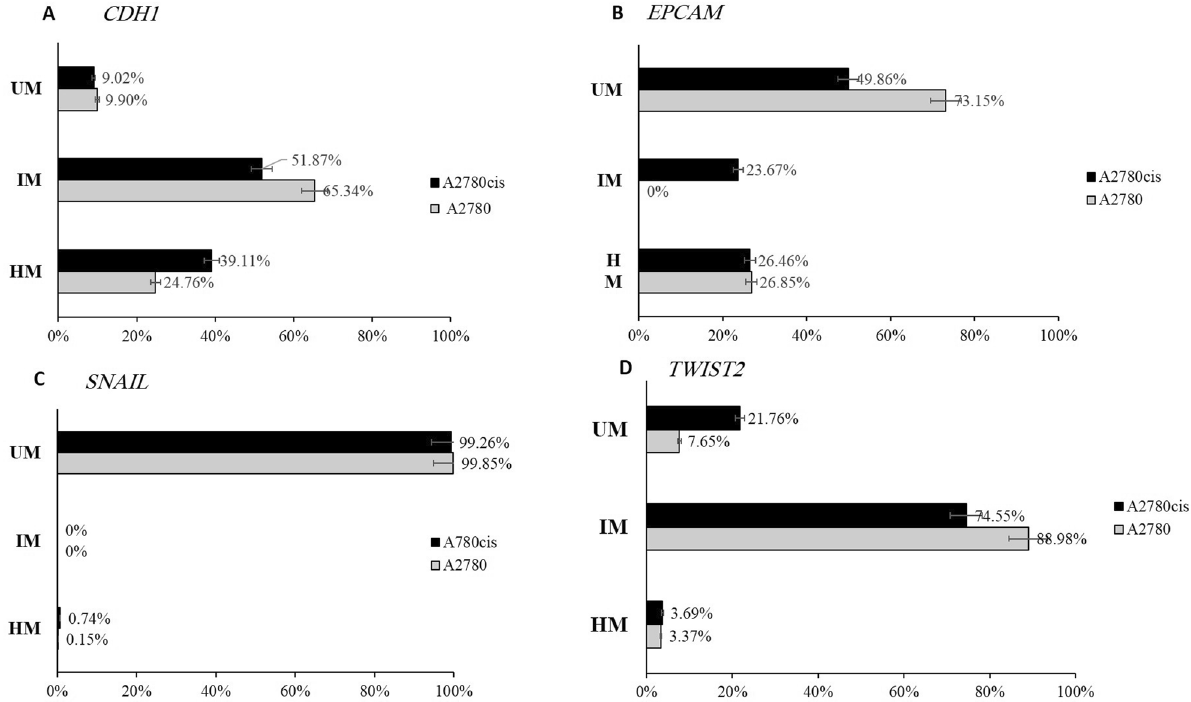
Figure 8. Methyscreen assay for CDH1 , EPCAM , SNAIL , and TWIST2 in A2780 and A2780cis cell lines. ( A ) Charts display the result of CDH1 assay as a percentage of each portion of DNA. ( B ) Charts display the result of EPCAM assay as a percentage of each portion of DNA. ( C ) Charts display the result of SNAIL assay as a percentage of each portion of DNA. ( D ) Charts display the result of TWIST2 assay as a percentage of each portion of DNA.